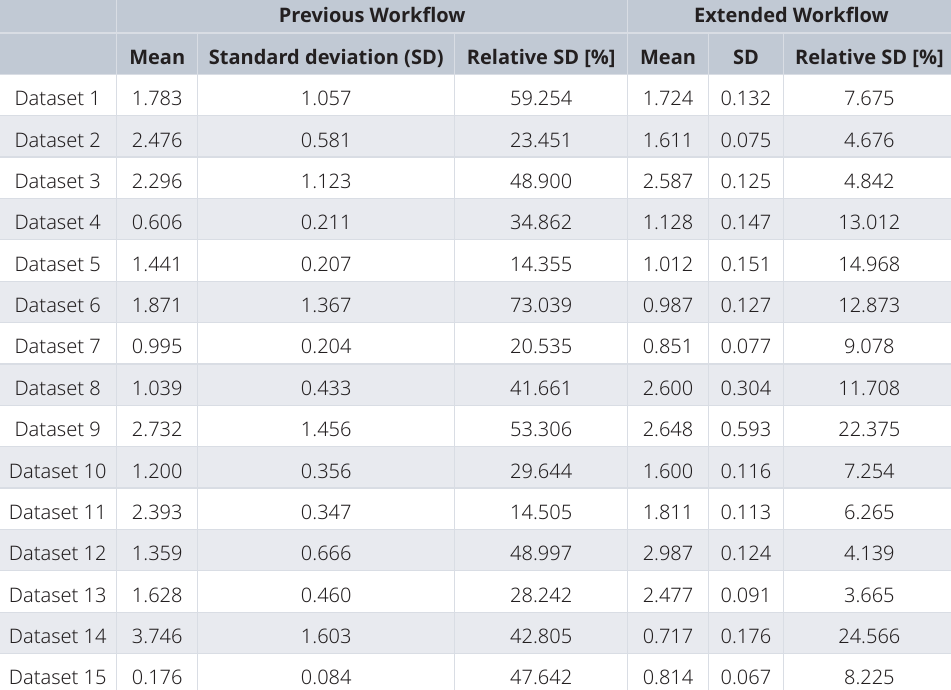
Table 3. Numerical data of repeated analysis with the previous and the extended workflow. Previous